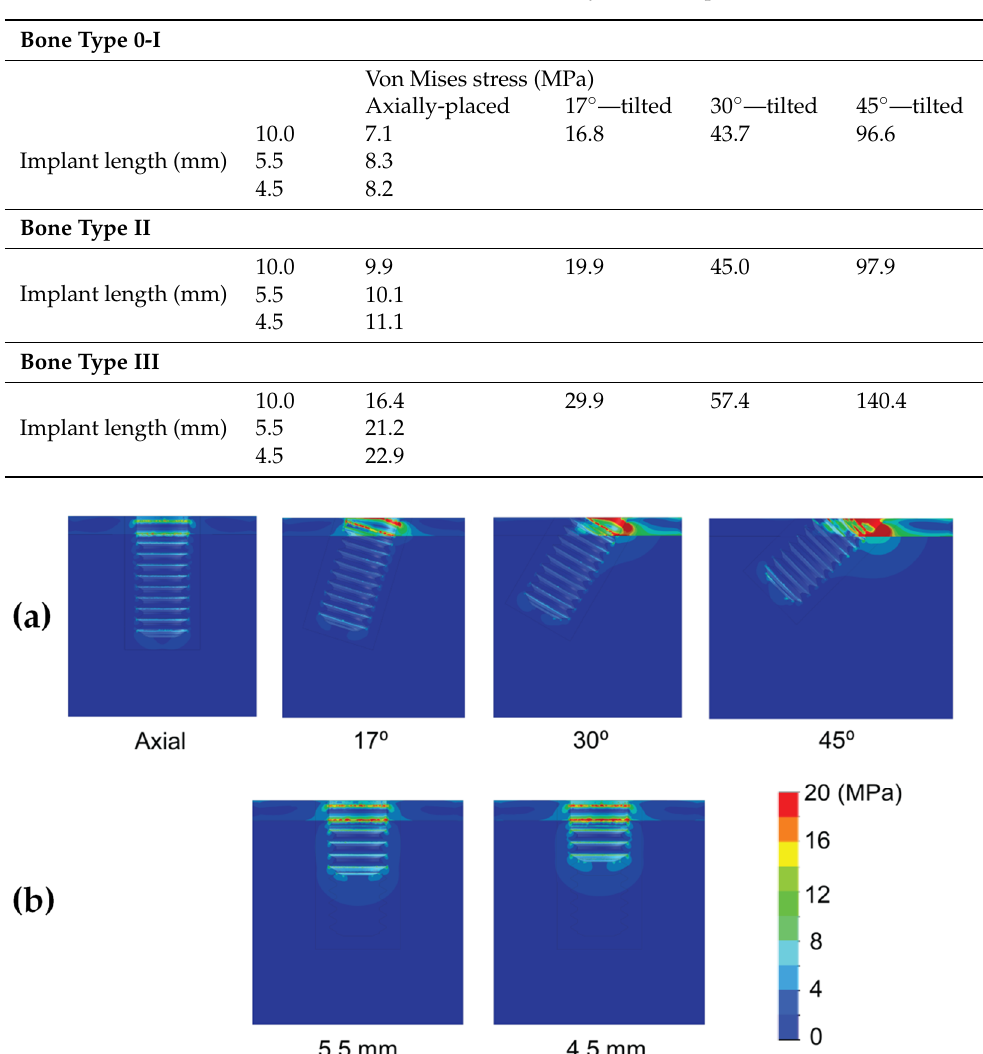
Table 3. Von Mises stresses (MPa) in bone tissue around delay-loaded implants. Axial load was 200 N. Bone Type 0-I